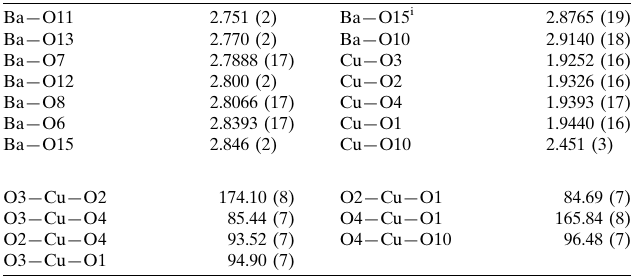
Selected geometric parameters (A˚ , (cid:2) ).